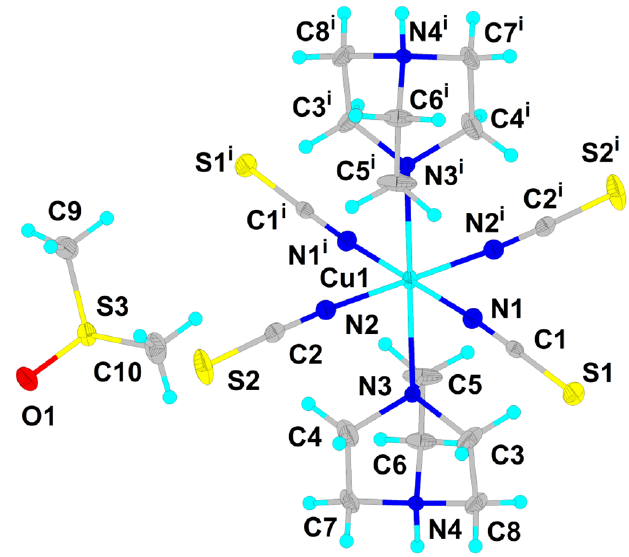
Figure 4. Molecular structure of 3 . Thermal ellipsoids are drawn at the 50% probability level. Symmetry operation: 1 − x, 1 − y, 1 − z (i).